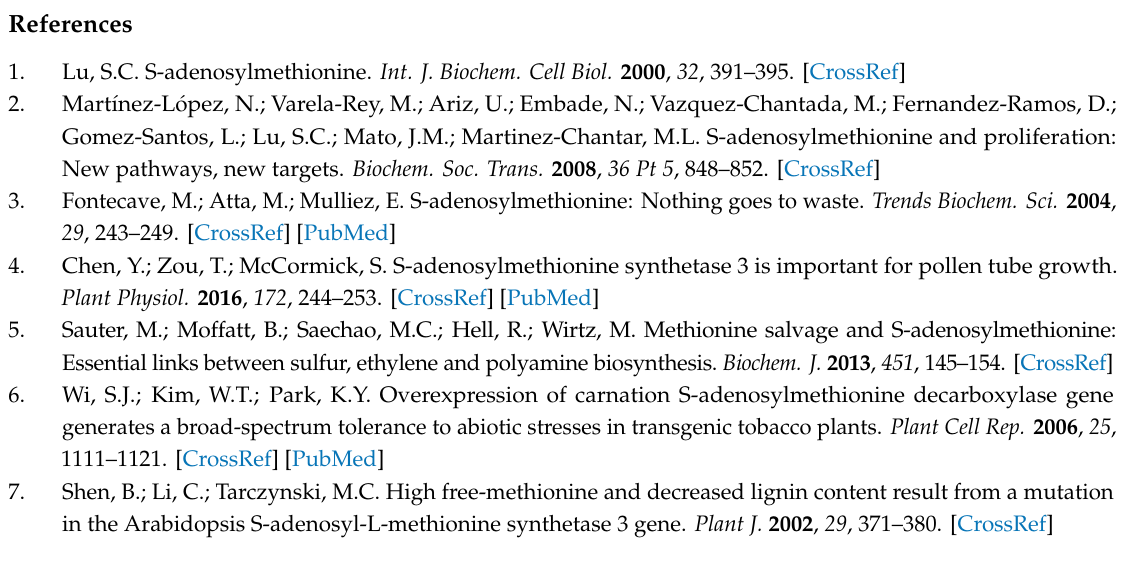
Table S1: List of primers used for real-time PCR, Table S2: Putative miRNAs targeting the transcripts of SAMS genes at an expectation level <